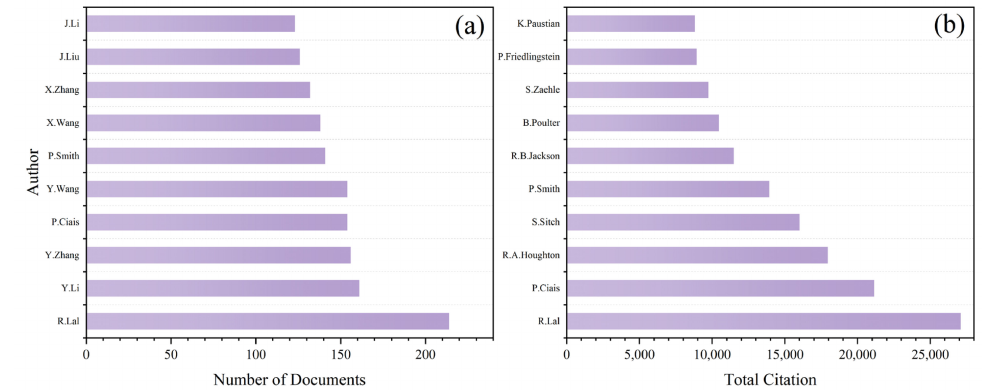
Figure 4. Top 10 Authors and Their Number of Publications in the Field of the Impact of Land Use Change on Soil Carbon Sequestration ( a ) and Top 10 Authors with the Most Cited Papers and the Number of Citations, and ( b ) from 1985 to 2021.